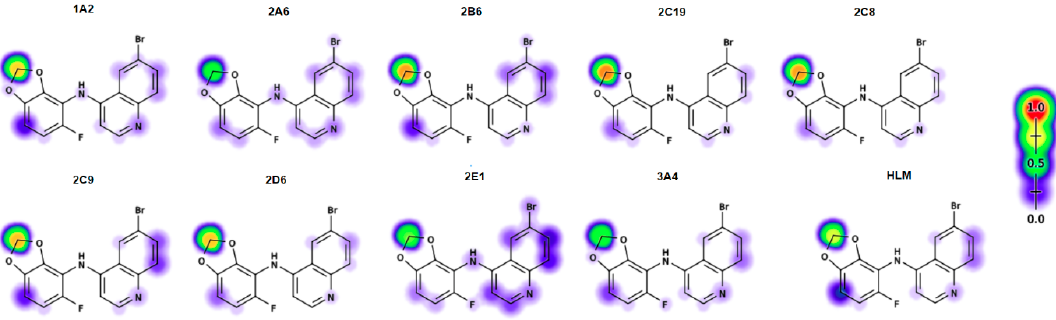
Figure 11. Compound 14 in XenoSite’s P450 Metabolism P450 1.0 algorithm.